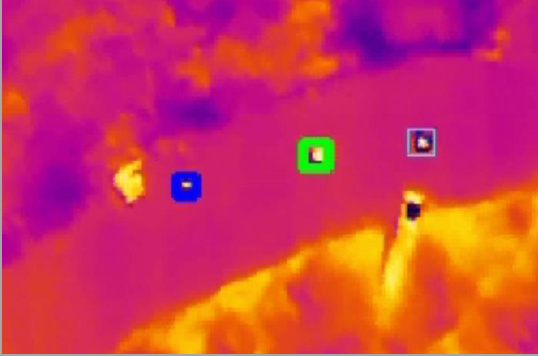
Figure 4b. Floats detected in thermal imagery We used Template Matching in OpenCV to detect the objects in RGB video. A template of the float was provided as input based on which it would be identified in each subsequent frame.